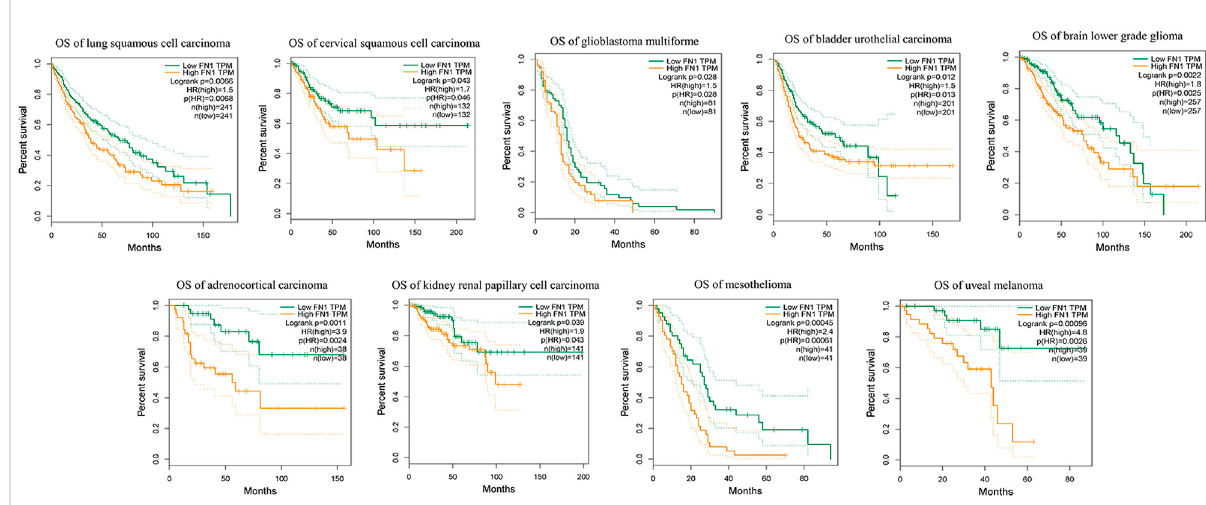
FIGURE 6 As a risk factor, FN1 not only affected the prognosis of patients with HNSCC, but also affects other types of squamous cell carcinomas or other types of carcinomas in TCGA